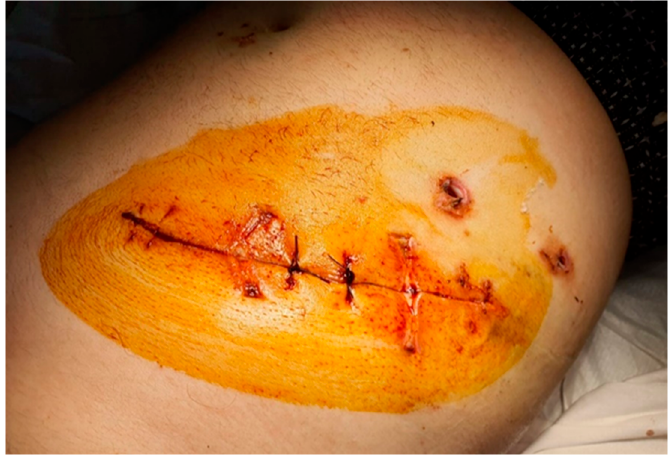
Figure 3. Incisional site after complete healing (15th day post